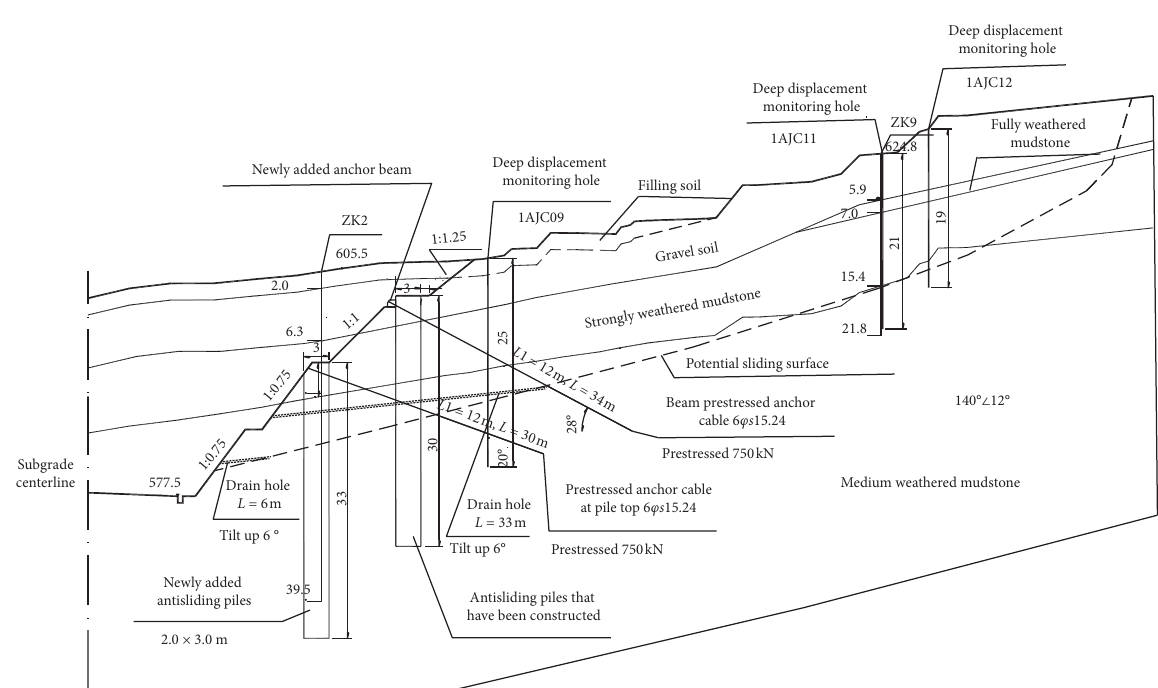
Figure 2: Cross-sectional view of the slope at K5